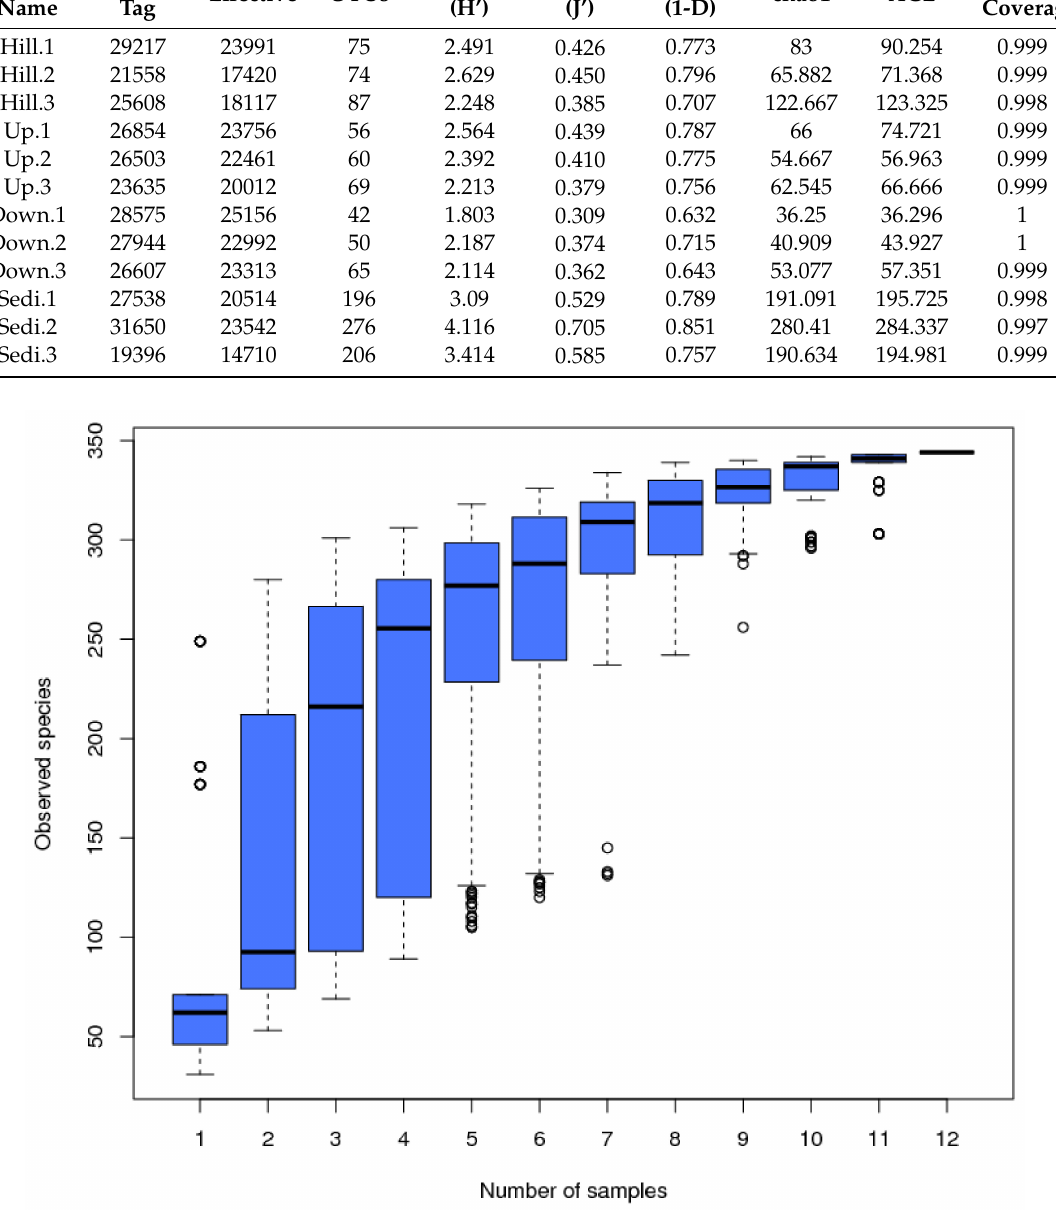
Figure 2. The species accumulation box-plot of the 12